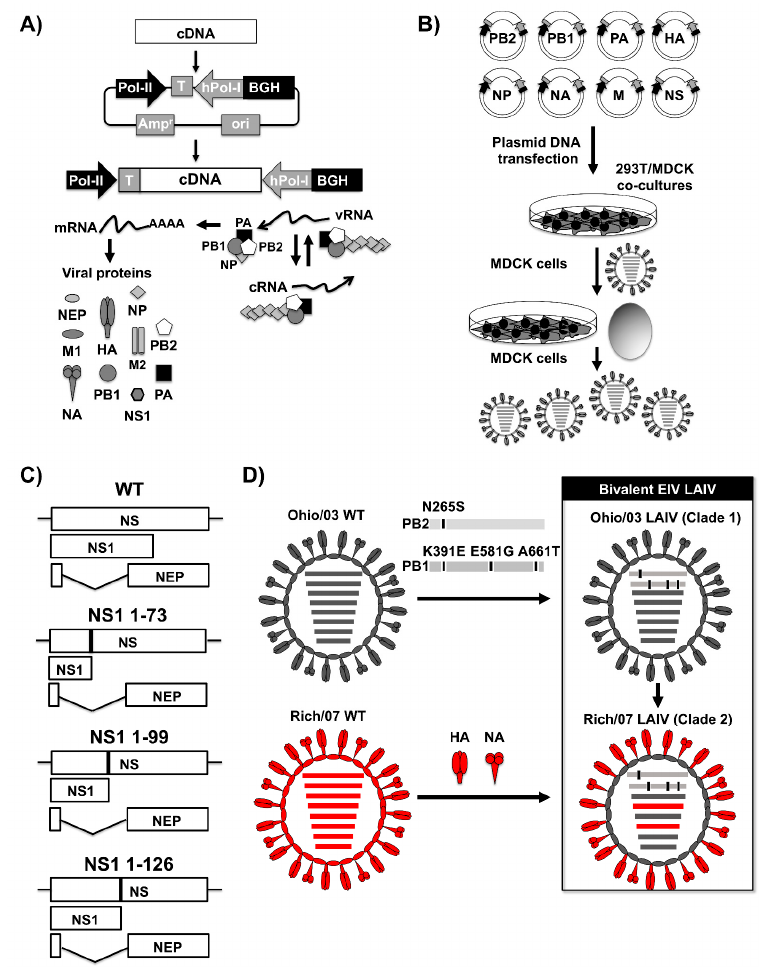
Figure 6. Generation of recombinant EIV LAIV using plasmid-based reverse genetic approaches: ( A